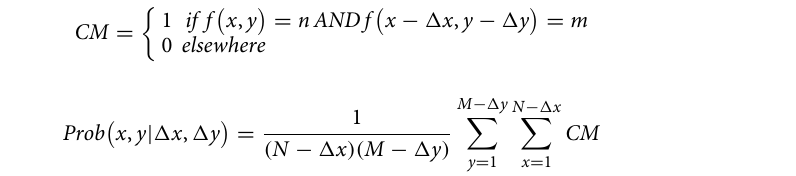
Therefore, each element Prob(x,y|∆x , ∆y) represents the relative frequency based on their neighbourhood relationship as illustrated in Fig. 6a. Subsequently, texture features including contrast, energy, correlation, and homogeneity features were calculated from the GLCM (see Table 5). Three parameters need to be considered to compose the best GLCM texture and intensity histogram feature set: (1) the number of clusters when constructing cluster images, (2) the parameters needed to identify pixel pairs when constructing GLCM, which are the distance (∆x = 1, ∆y = 0) and (3) the orientation (0°, 45°, 90°, 135°). The distance (∆x = 1, ∆y = 0) was fixed because the size of patch images was relatively small. In our study,